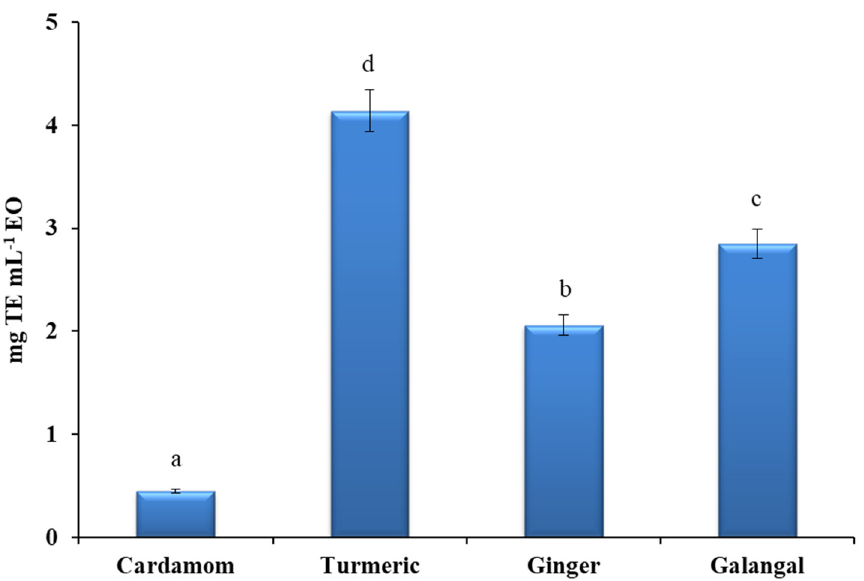
Figure 6. Antioxidant activity of EOs expressed as mg trolox equivalents per milliliter of essential oil (mg TE mL − 1 EO). All measurements were performed in duplicate. For comparison of the mean values, one-way ANOVA followed by S-N-K post hoc were applied. Different superscript letters (a, b, c, d) indicate a statistical difference in AA of evaluated EOs ( p < 0.05).